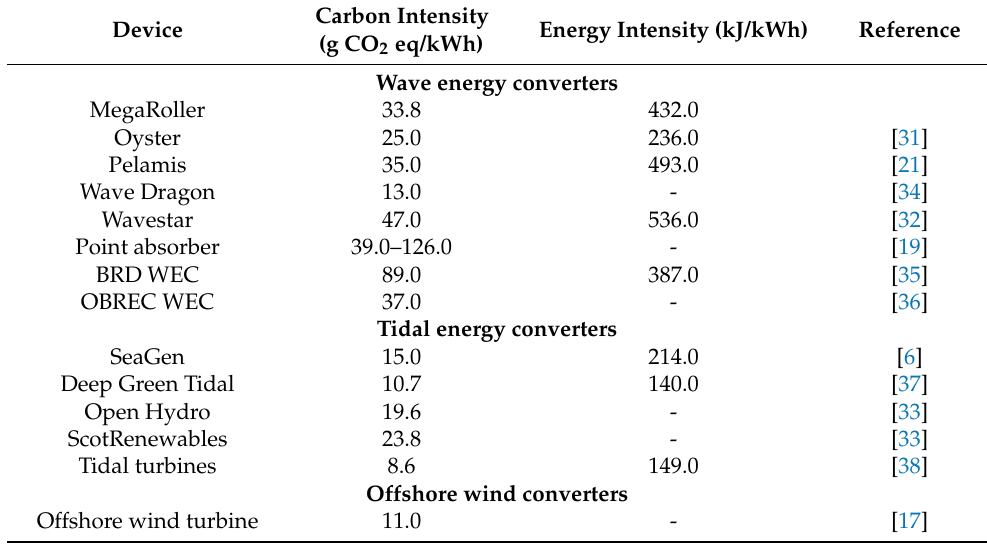
Table 7. Carbon footprint and embodied energy estimates for a selection of MRE production